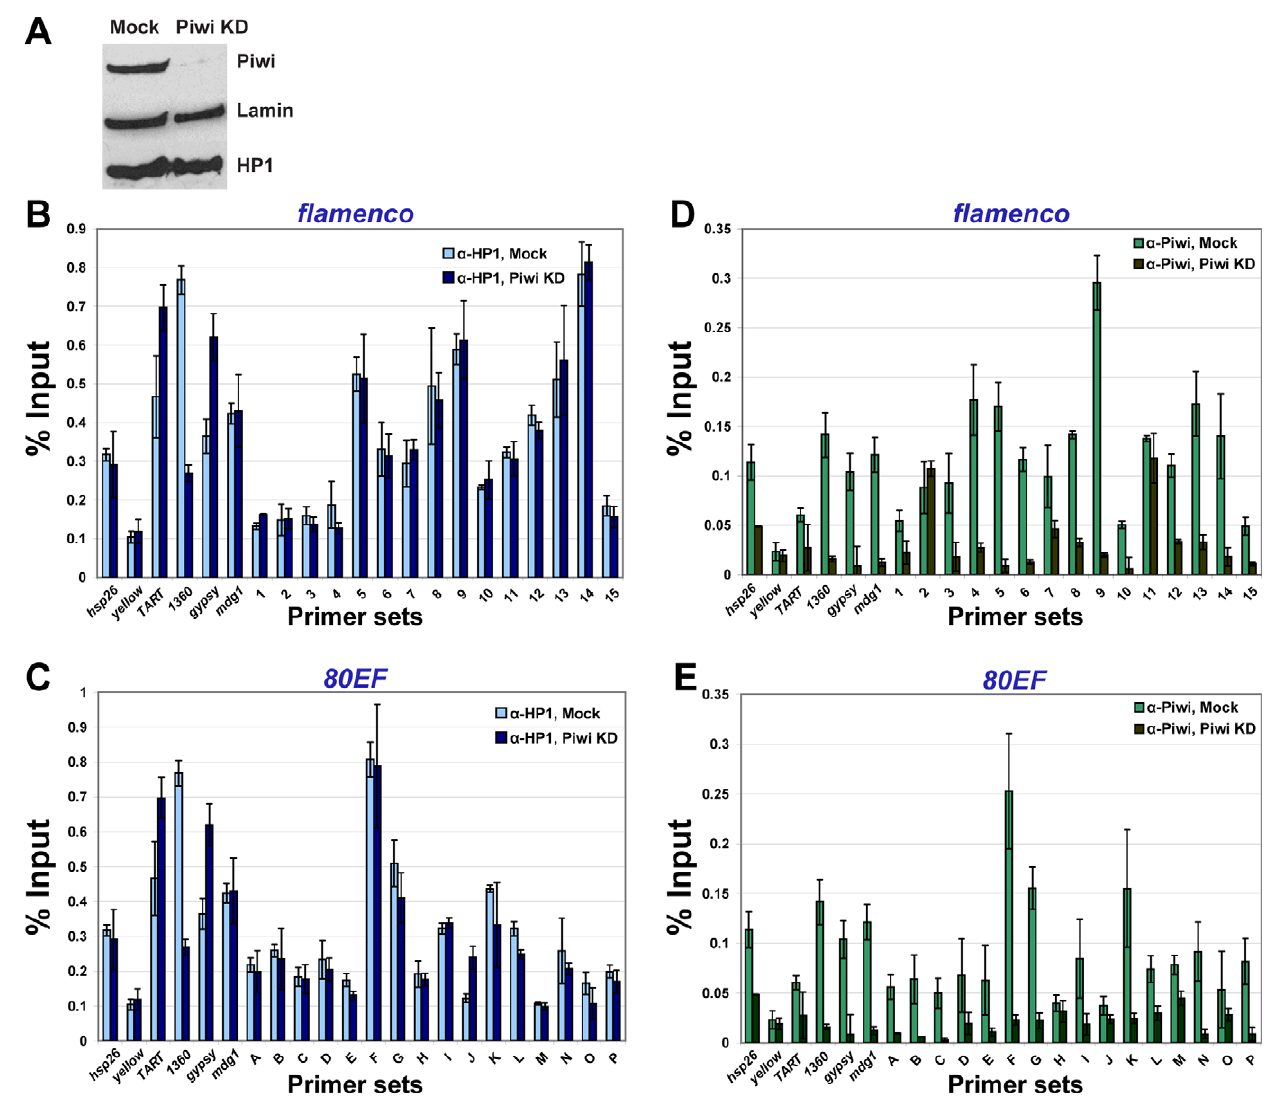
Figure 5. Depletion of Piwi from ovarian somatic follicle cells does not affect HP1 recruitment to piRNA clusters. (A) Western blotting of Piwi, HP1 and Lamin in OSC cells that were either mock treated (left lane) or treated with siRNA directed against piwi (right lane, Piwi KD). ChIP at flam (B,D) and 80EF (C,E) piRNA clusters in mock treated and Piwi KD OSC cells with antibodies specific to HP1 (B,C) or Piwi (D,E).